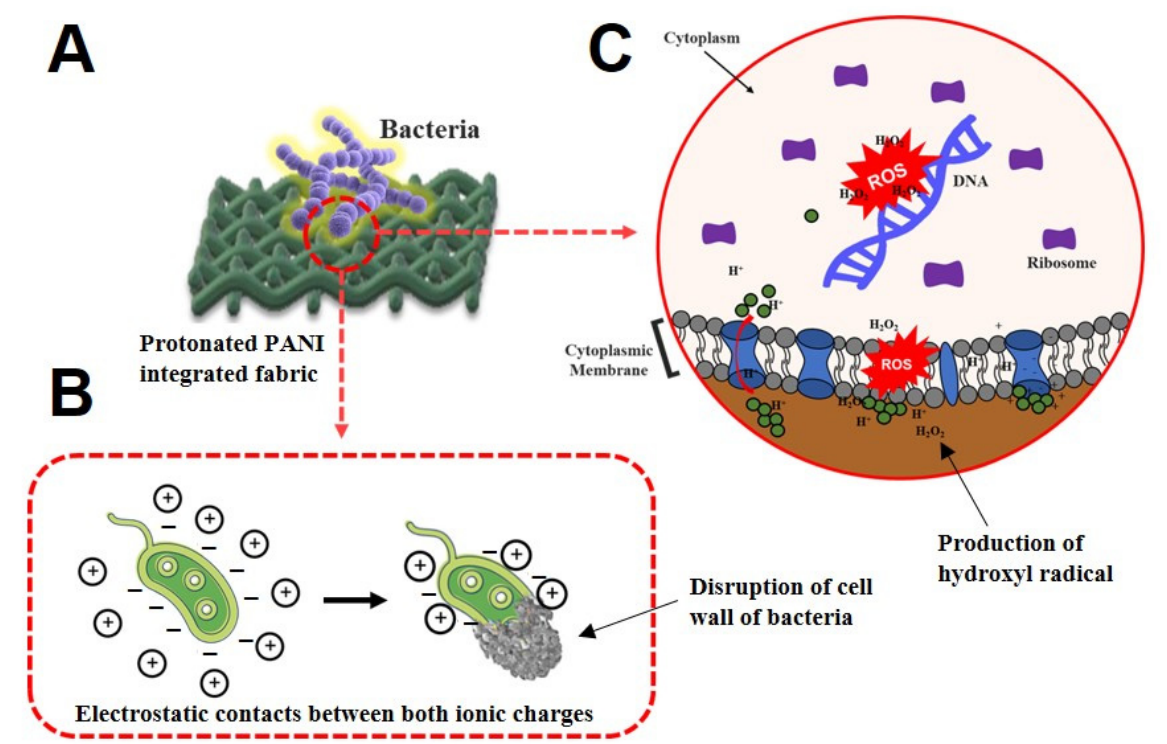
Figure 5. Two possible mechanisms can contribute to the antibacterial activity of protonated PANI fabrics against bacteria. ( A ) The illustration of protonated PANI-integrated fabric when exposed to the bacteria strain. ( B ) Electrostatic contact of cationic compounds in protonated PANI fabric with the anionic charges in the bacterial membrane. ( C ) The disruption mechanism of hydroxyl radicals formed by the production of hydrogen peroxide by PANI reacting with the atmosphere.